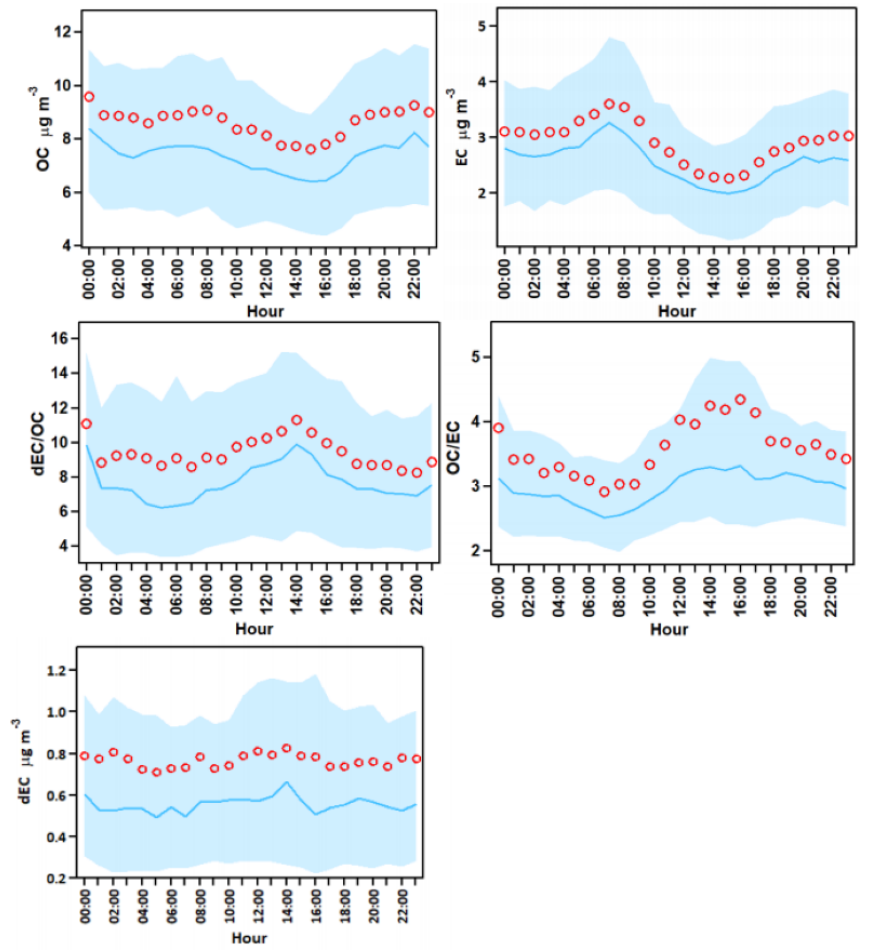
Figure 6. Diurnal variations in OC, EC and dEC concentrations and dEC / OC and OC / EC ratios during the study period. The boundary of the shaded area indicates the 25% and 75% percentile, respectively. The red circle marks the average, while the blue line marks the